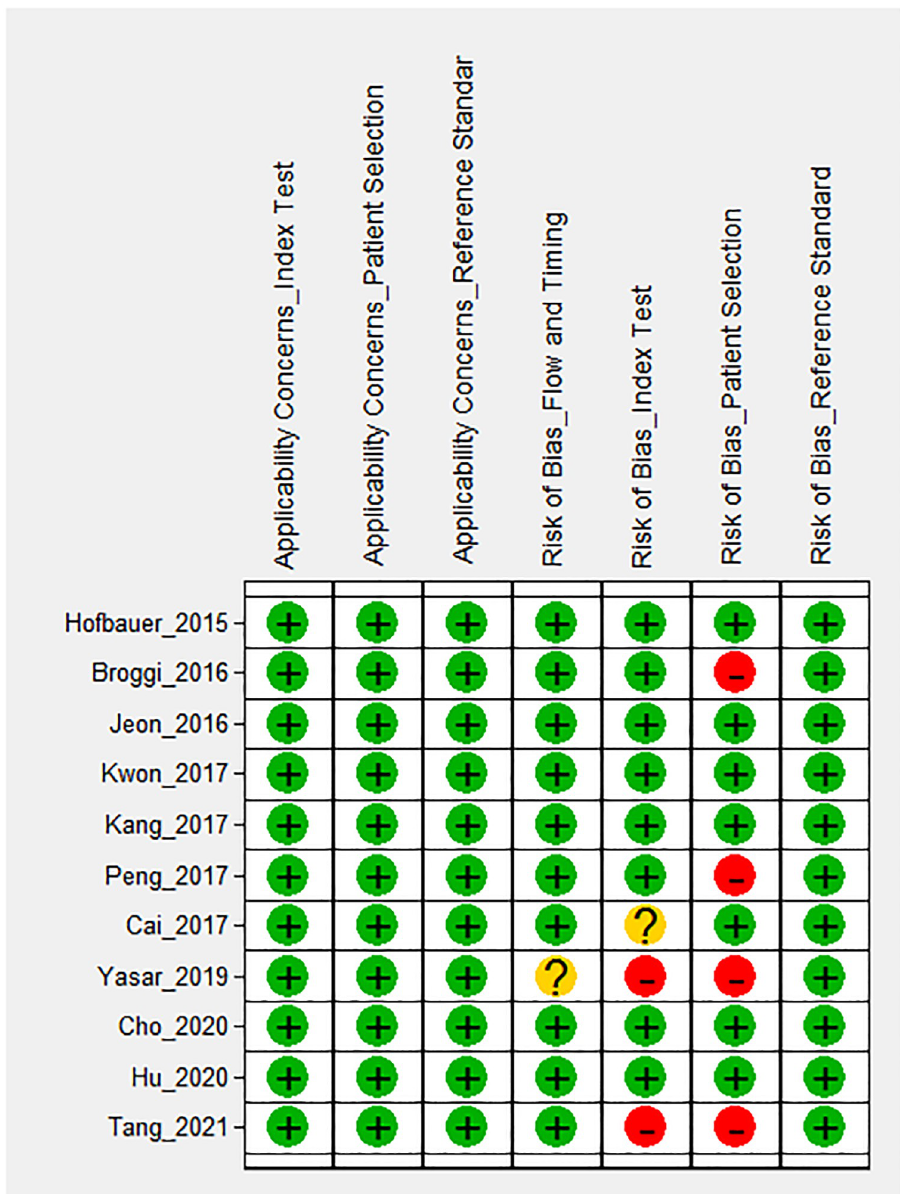
Fig 2. Summary of the methodological quality of the studies evaluated by the quality assessment of diagnostic accuracy studies-2 (QUADAS-2).